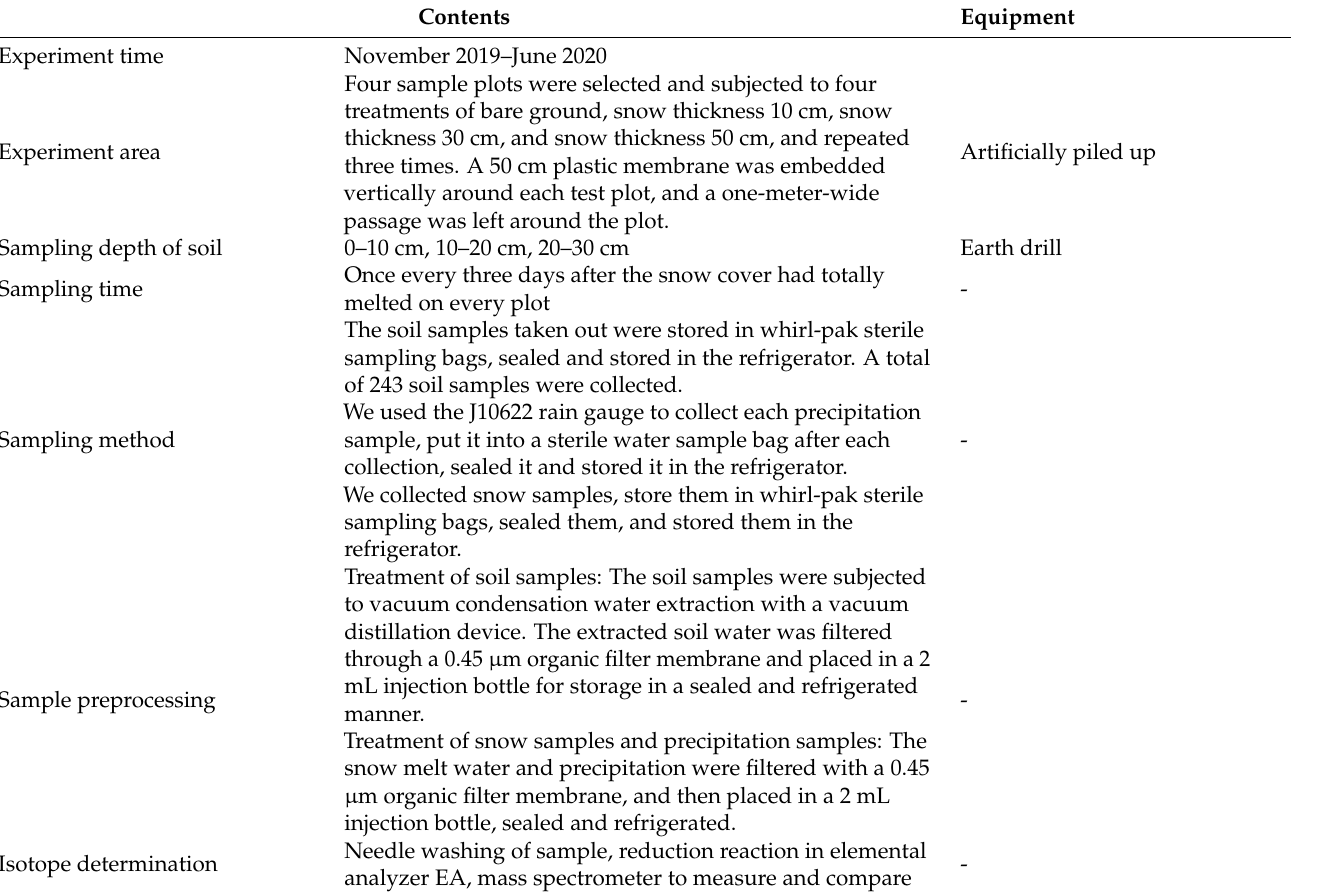
Table 1. The diagram of the